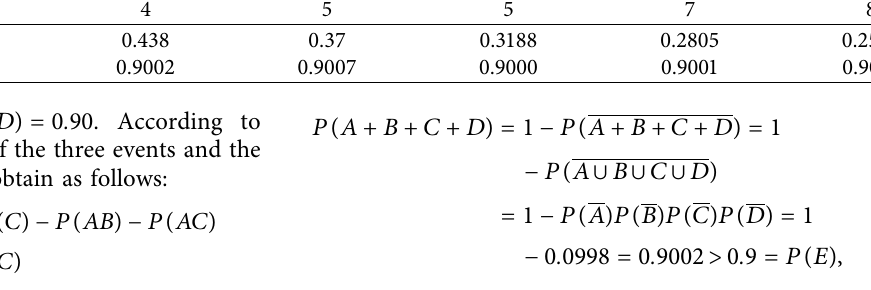
Table 2: A comparative experiment of solving problems by multiple cobblers cooperating with Zhuge Liang alone. Cobbler